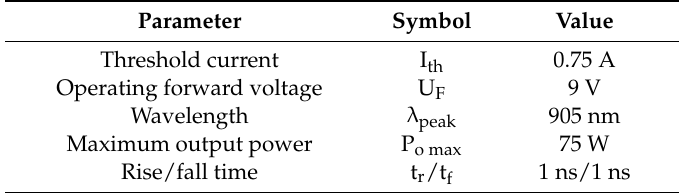
Table 2. Near Infra-Red (NIR) laser catalogue typical parameters (room